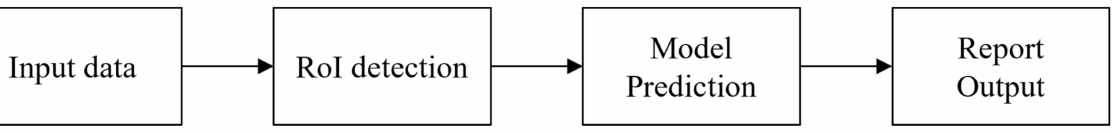
Figure 2. Machine learning pipeline development for both model training and model deployment in a clinical setting. ROI = Region of